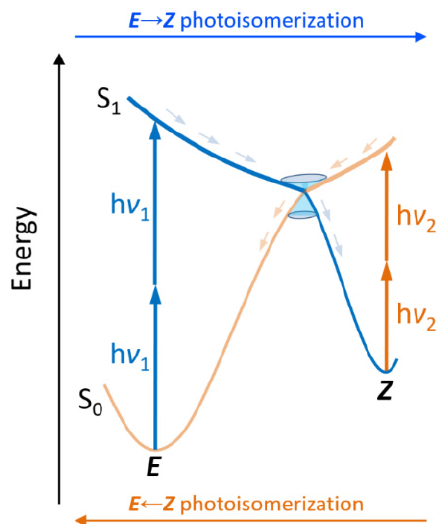
Figure 1. Simplified scheme of a E / Z molecular photoswitch acting by two-photon absorption, including two different frequencies: ν 1 for E → Z (blue) and ν 2 for E ← Z (orange) photoisomerization. After absorption to the excited state (S 1 ) a conical intersection can ideally funnel the formation of the photoproduct or internal conversion to restore the initial photoisomer.